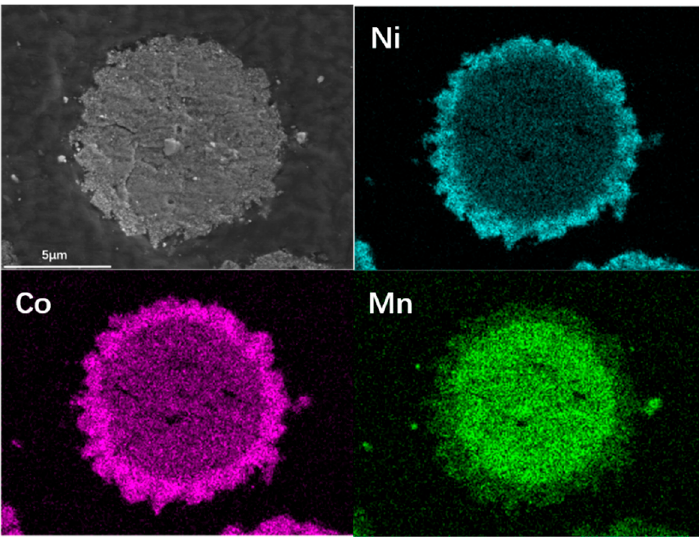
Figure 6. SEM-EDX mapping photograph for Ni, Co and Mn in a single particle obtained by hydrothermal treatment. R M = 1:1:1 (Ni:Co:Mn); C (NH4)2CO3 = 0.1 mol·L − 1 ; T h = 180 °C; and t h = 24 h.